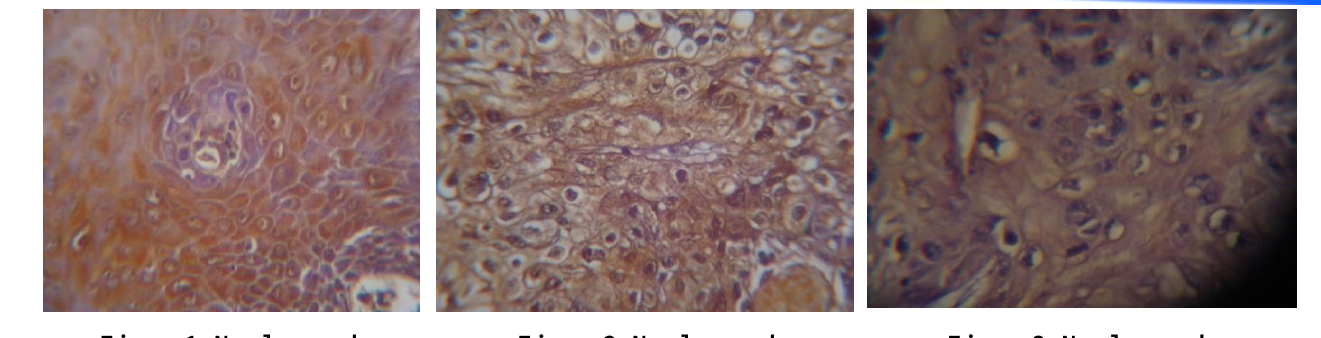
Figure 1: Nuclear and cytoplasmic expression of DNMT3B in OSCC (X40)